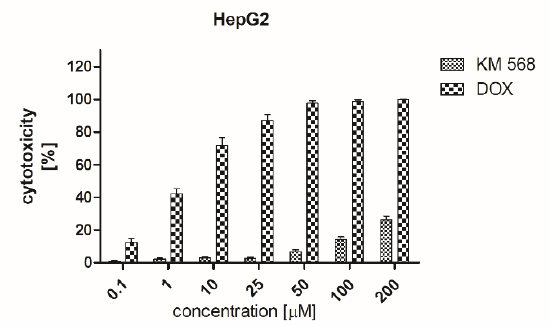
Figure 8. Results of cytotoxicity evaluation of compound KM-568 and doxorubicin (DOX) in an HepG2 cell line in an LDH assay. Results presented as mean ± SD from three samples.